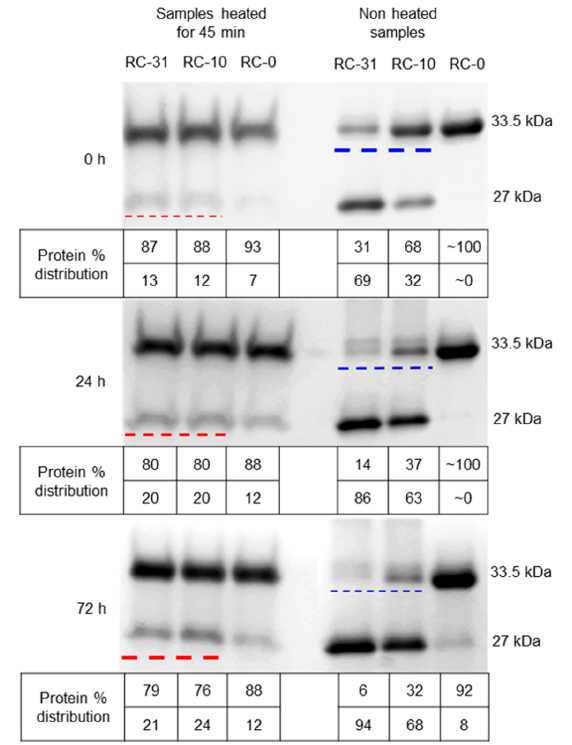
Figure 2. Solubilized OmpT IBs reconstituted in detergent micelles were monitored for autoproteolysis over a time period of 72 h: Solubilized OmpT IBs were refolded in the presence of 31, 10, or 0 mM DodMe 2 NPrSO 3 detergent and denoted as RC-31, RC-10, and RC-0, respectively. Samples incubated at 4 °C were collected after 0, 24, and 72 h of refolding and analyzed using SDS-PAGE: Left panel—samples heated for 45 min prior to gel loading, and right panel—samples loaded without any heating (non-heated samples) on SDS-PAGE. The thickness of the red and blue dashed lines reflects increasing and decreasing protein band intensities. Note: We observed at least one additional higher molecular weight band (slightly above the 33.5 kDa) in the non-heated RC-31 and RC-10 samples of 24 and 72 h which were also observed by Kramer et al. (2000) [19]. These are most likely OmpT complexed with LPS.